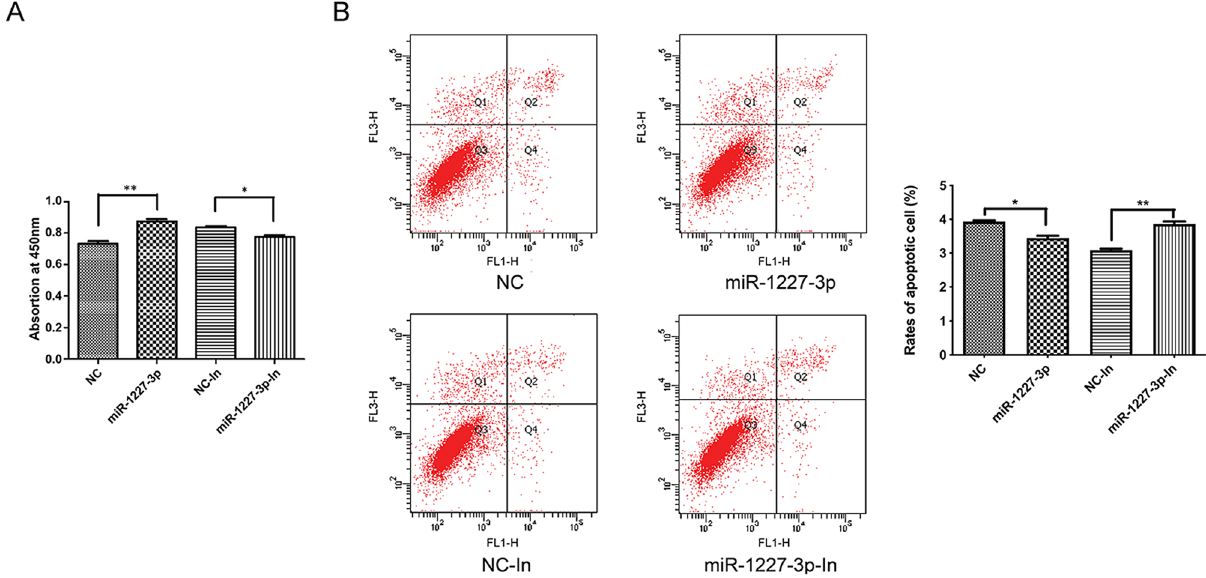
Figure 2. Effect of miR-1227-3p on HTR-8/SVneo cells proliferation and apoptosis. ( A ) CCK-8 assay was performed to detect the proliferation of HTR-8/SVneo cells treated with miR-1227-3p mimics or inhibitor. ( B ) Flow cytometry assay was carried out to examine the cell apoptosis of HTR-8/SVneo cells transfected with miR- 1227-3p mimics or inhibitor. Asterisks denote significant differences from controls (* P < 0.05 and ** P <